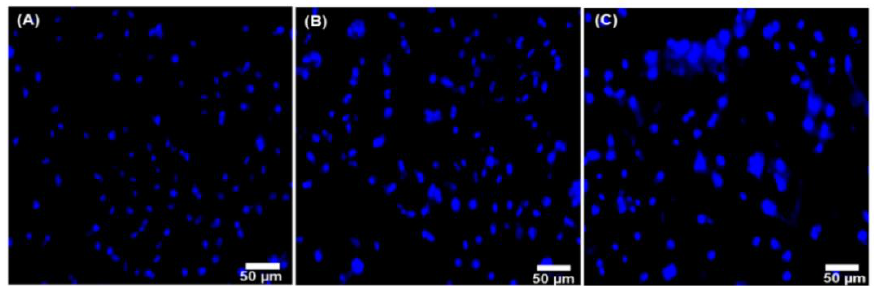
Figure 8. Hoechst 33342 staining images of alkaline treated nano HA at different concentrations, image ( A ) control ( B ) 10 µ g/mL, and ( C ) 500 µ g/mL, Scale bar—50 µ m.